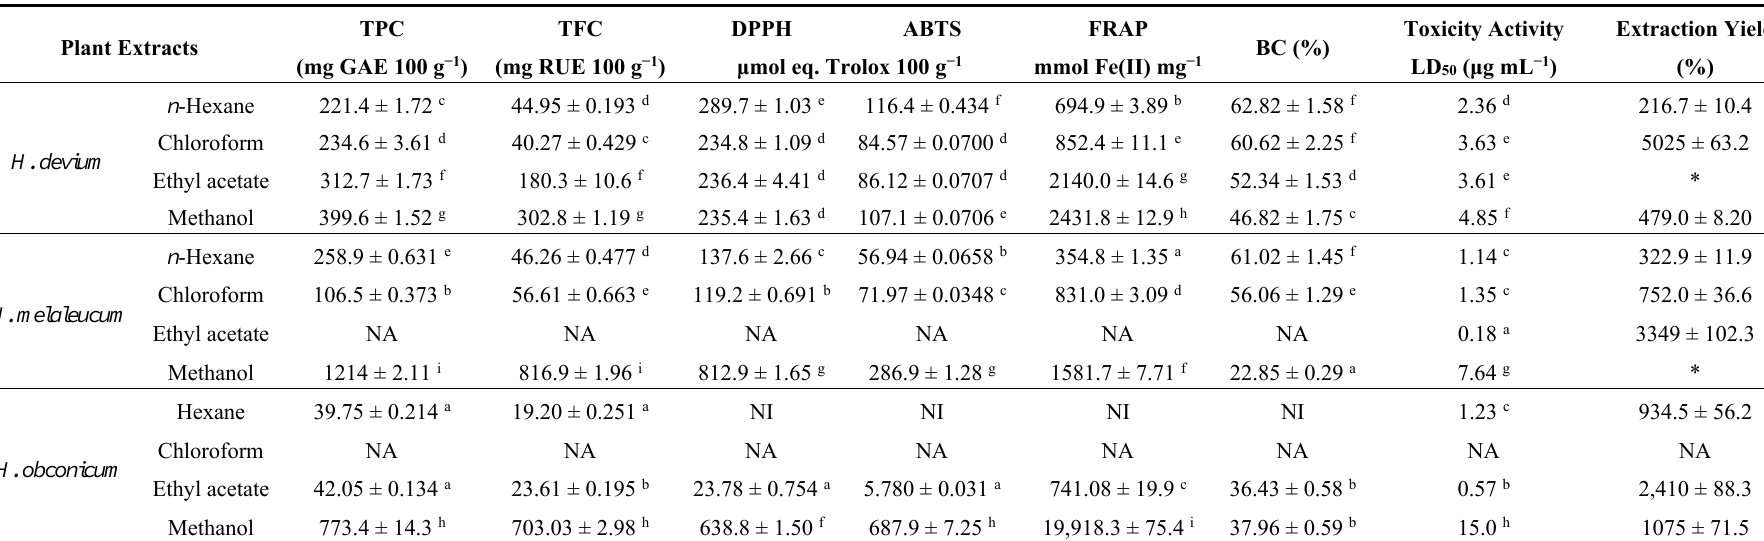
* Values represented as mean ± SD ( n = 3); Means not sharing the same letter in the same column are significantly different at p < 0.05 probability level; NA—Not Analyzed; NI—No Inhibition